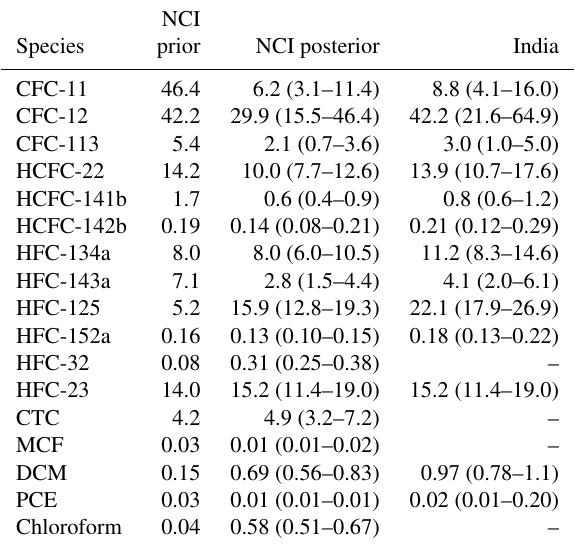
Table 5. Posterior mean halocarbon emission estimates reported in TgCO 2 eq . yr − 1 for northern–central India and the whole of India. The 5th and 95th percentile ranges are shown in parentheses. Emis- sions totals for the whole of India are not presented for HFC-32, CTC, MCF and chloroform, as scaling to a national total was not considered appropriate for these